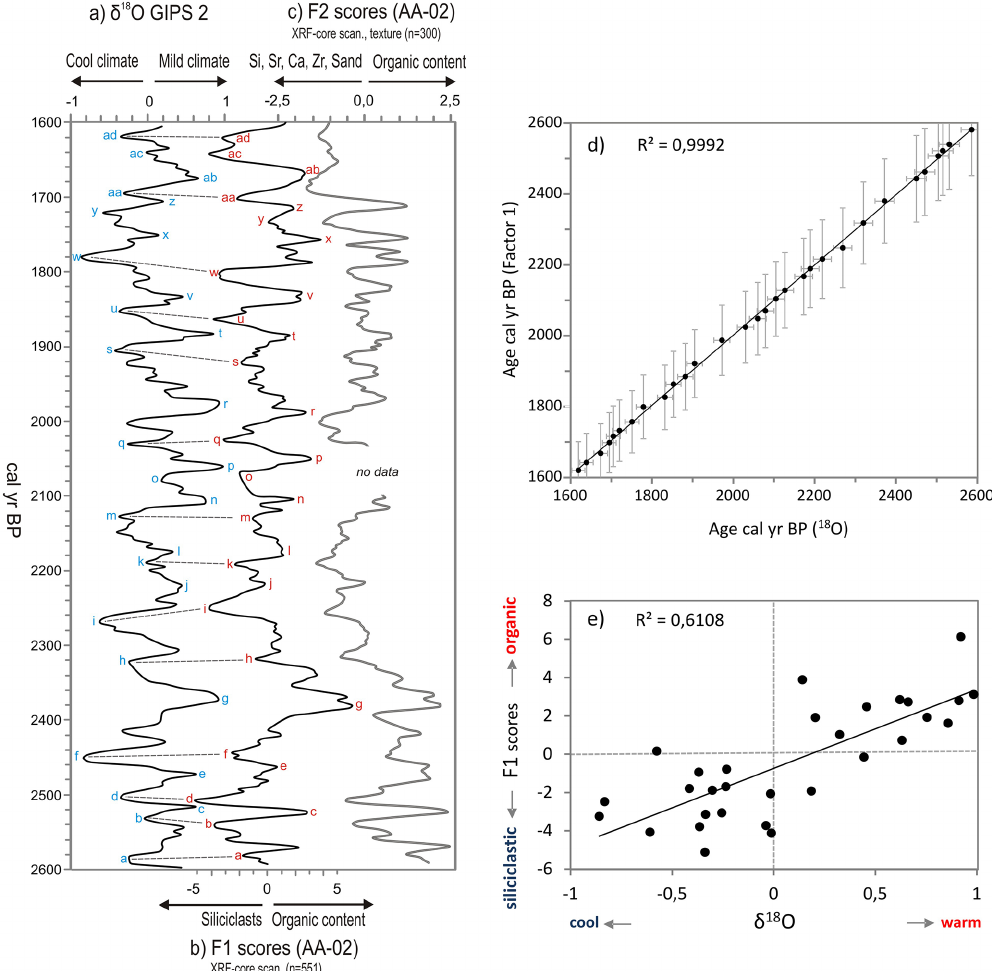
Figure 5. Comparison of the (a) δ 18 O isotope record from the Greenland Ice Sheet Project 2 (GISP2; Stuiver et al., 1997) and (b) factor 1 scores of scanned core AA-02 samples from 2600 to 1600calyrBP (3-data-smoothed, approximately 9 years). Correspondence of cool climate pulses and siliciclasts (negative values) are assigned by dashed lines. Maxima and minima of both series ( δ 18 O and factor 1) were labelled with characters from “a” to “ad”. (c) Scores of scanned core AA-02 samples and grain size are plotted for comparison. (d) Compar- ison of maximum and minimum local events a–ad ( N = 30; (a, b) ) of the δ 18 O isotope record from the Greenland Ice Sheet ( x axis; GISP2; Stuiver et al., 1997) and factor 1 scores of scanned core AA-02 samples ( y axis) from 2600 to 1600calyrBP. Error bars shown at ± 5.0% for factor 1 scores according to 14 C chronology after calibration and at ± 1.0% for 18 O (GISP2) according to Stuiver et al. (1997) indicate that the timing of the selected events is consistent. (e) Scatter plot between δ 18 O and F1 scores of maximum and minimum local events